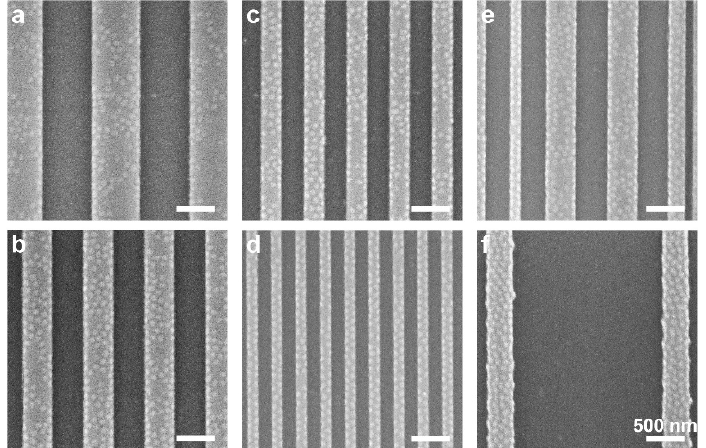
Figure 4. ( a – d ) SEM images of films cast on substrates featuring 31 nm-deep trenches and equal plateau and trench widths: ( a ) 640 nm; ( b ) 400 nm; ( c ) 280 nm; ( d ) 160 nm. Nominal film thickness is 23 nm. Bright and dark stripes correspond to the plateaus and trenches, respectively. ( e ) Image of plateaus and trenches with varying lateral dimensions. ( f ) Image of wider (2 µ m) trench with narrow 320 nm plateau. All scale bars represent 500